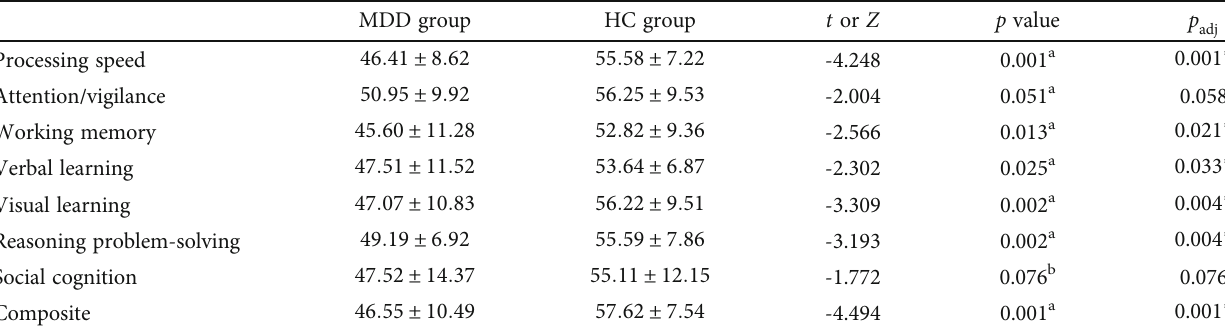
Table 2: Comparison of CF testing results in the two groups.